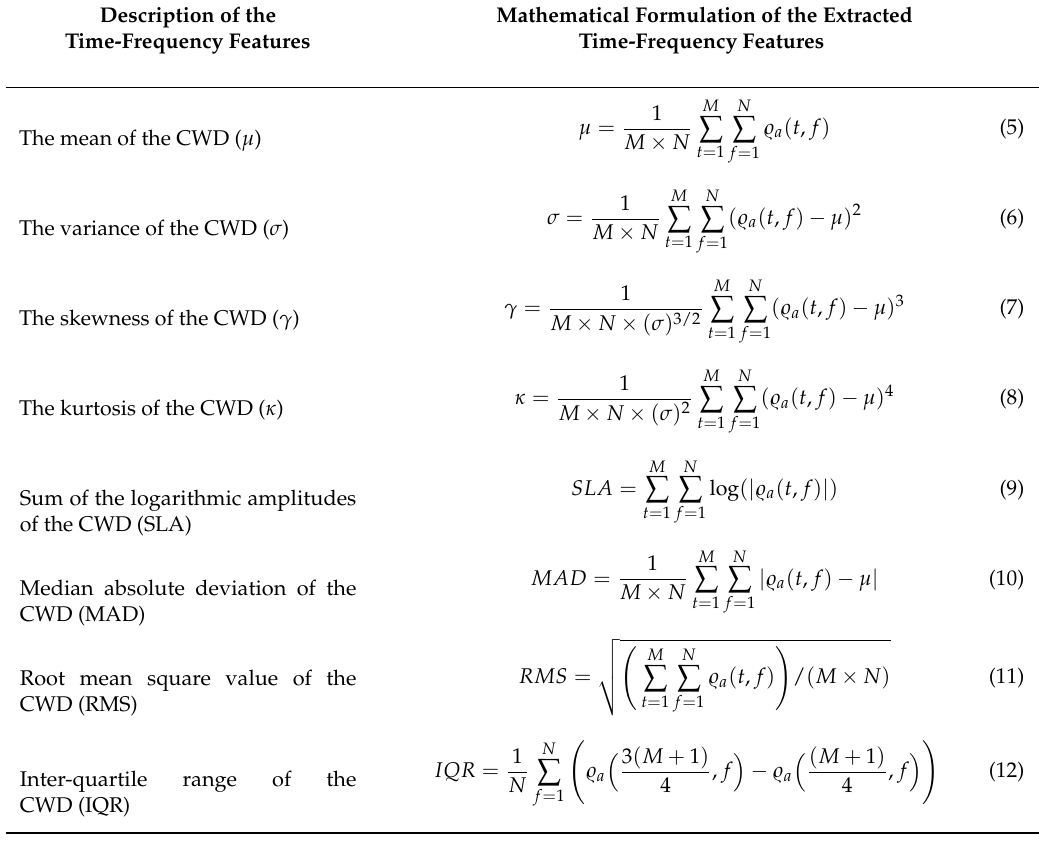
Table 2. The extracted time-frequency features obtained by extending eight time-domain features to the joint time-frequency-domain. SLA, sum of the logarithmic amplitudes.